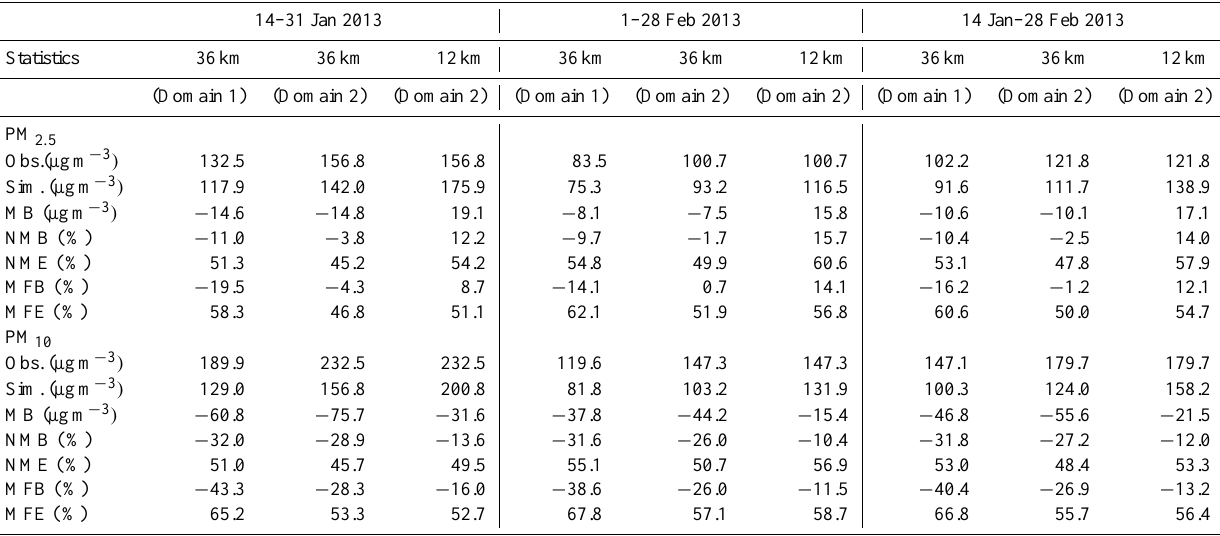
Table 3. Performance statistics of PM 2 . 5 and PM 10 concentrations over Domain 1 at 36km resolution and Domain 2 at 36 and 12km